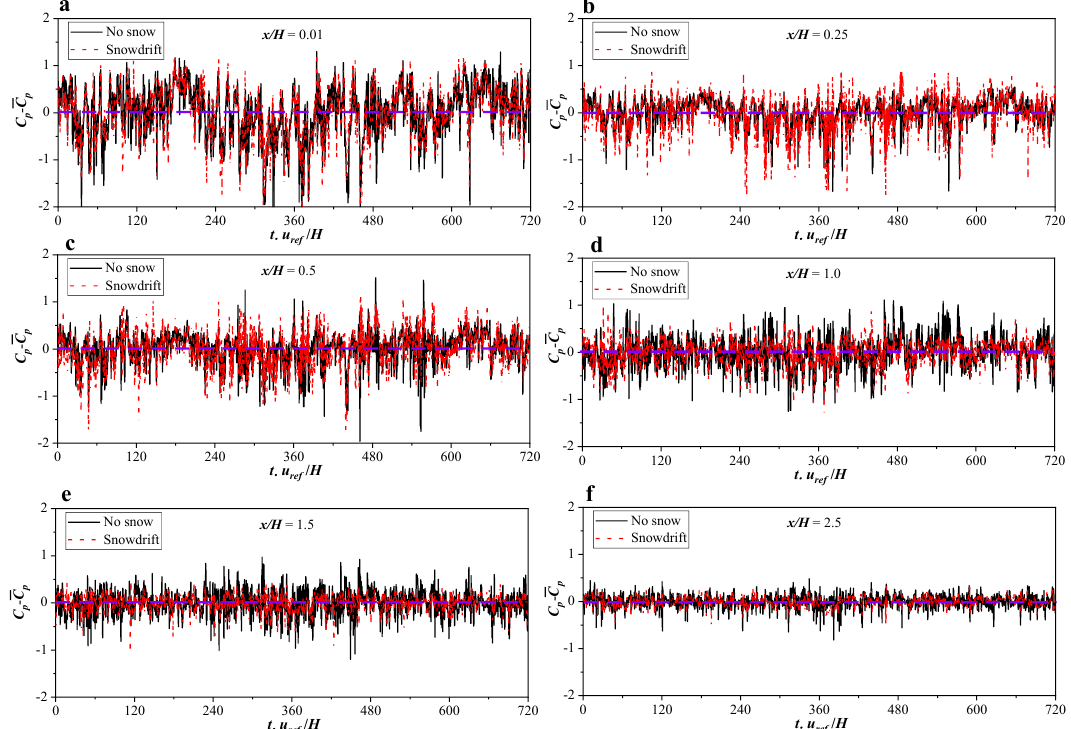
Figure 15. The time history of wind pressure at monitoring points (( a ) x/H = 0.01; ( b ) x/H = 0.25; ( c ) x/H = 0.5; ( d ) x/H = 1.0; ( e ) x/H = 1.5; ( f ) x/H = 2.5).